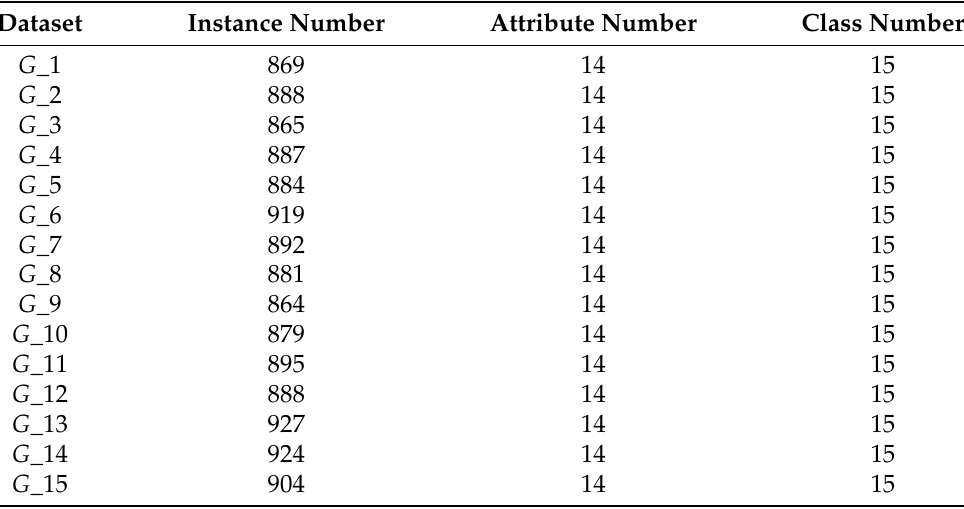
Table 3. Descriptions of 15 groups from Flavia dataset used in the